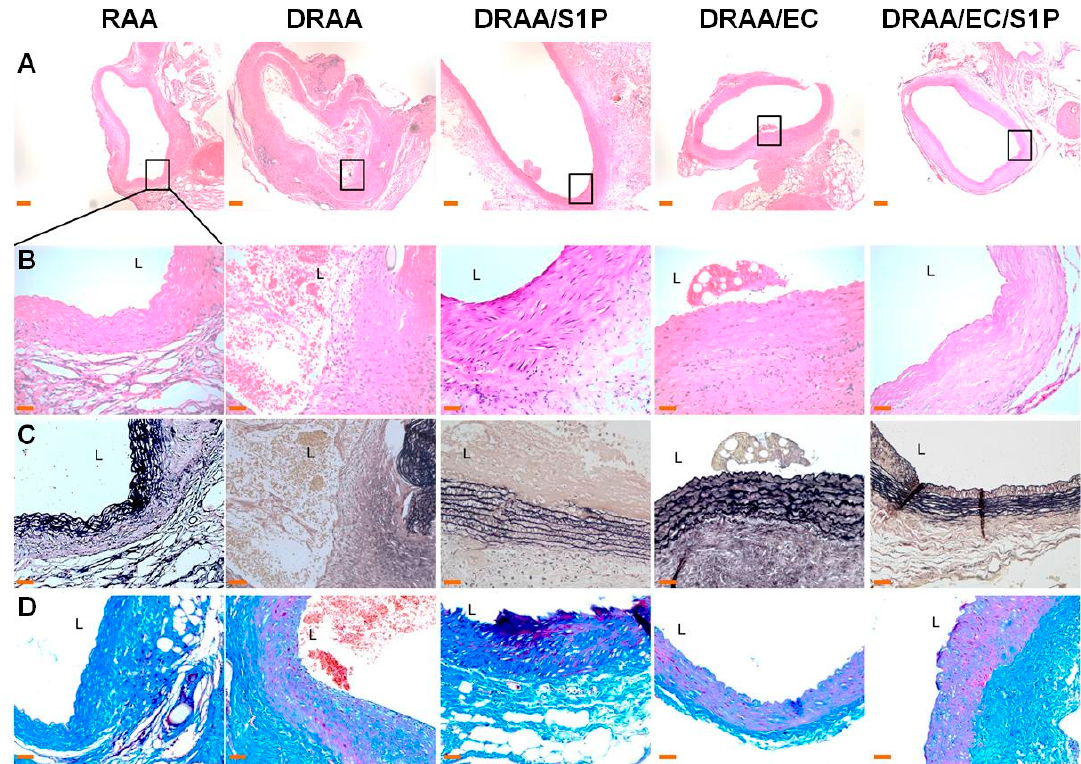
Figure 5. Histological stains of explanted grafts at Day 14. ( Panels A – D ) show rat abdominal aorta stained using H&E (( A ): Magnification, 40×, ( B ): Magnification, 400×), EVG (( C ): Magnification, 200×), and Masson’s trichrome (MT) (( D ): Magnification, 200×). Stained sections show distributions of elastin (black in EVG), smooth muscle (red in MT), and collagen (blue in MT) (left column: RAA, left-middle column: DRAA, middle column: DRAA/S1P, right-middle column: DRAA/EC, and right column: